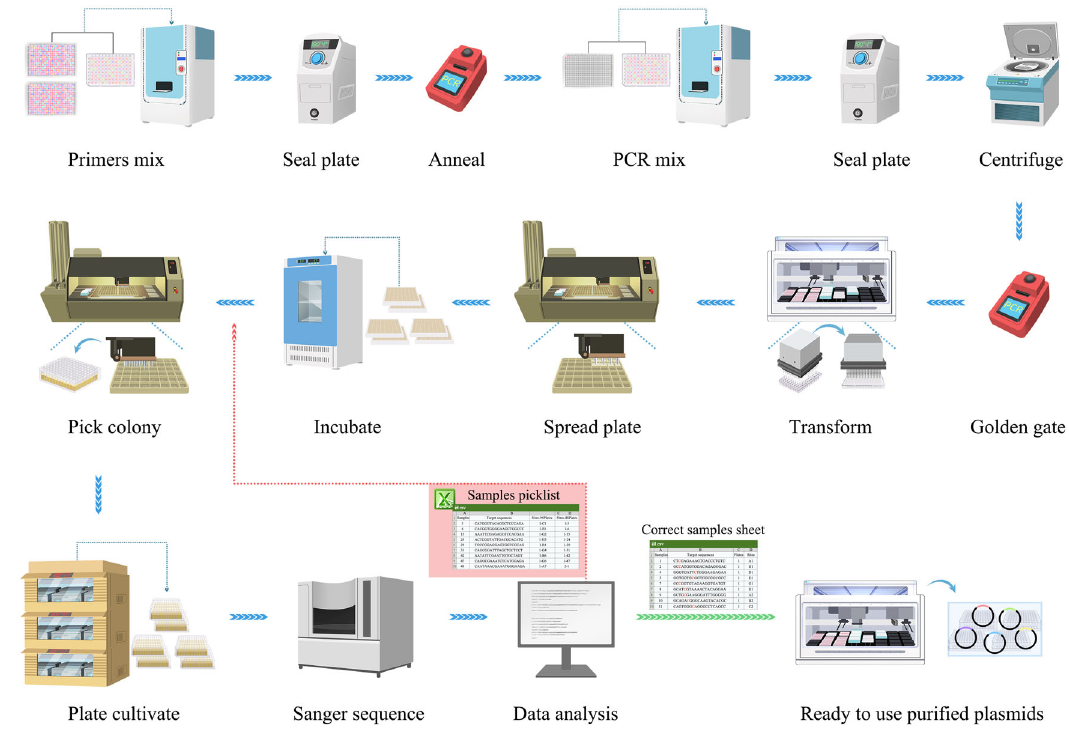
Fig. 2 | Schematic Overview of the automated gRNA plasmids construction work fl ow. Thedetailedproceduresandequipmentarelisted.Theredarrowmeans the incorrect information of assembled samples, and more colonies need to be